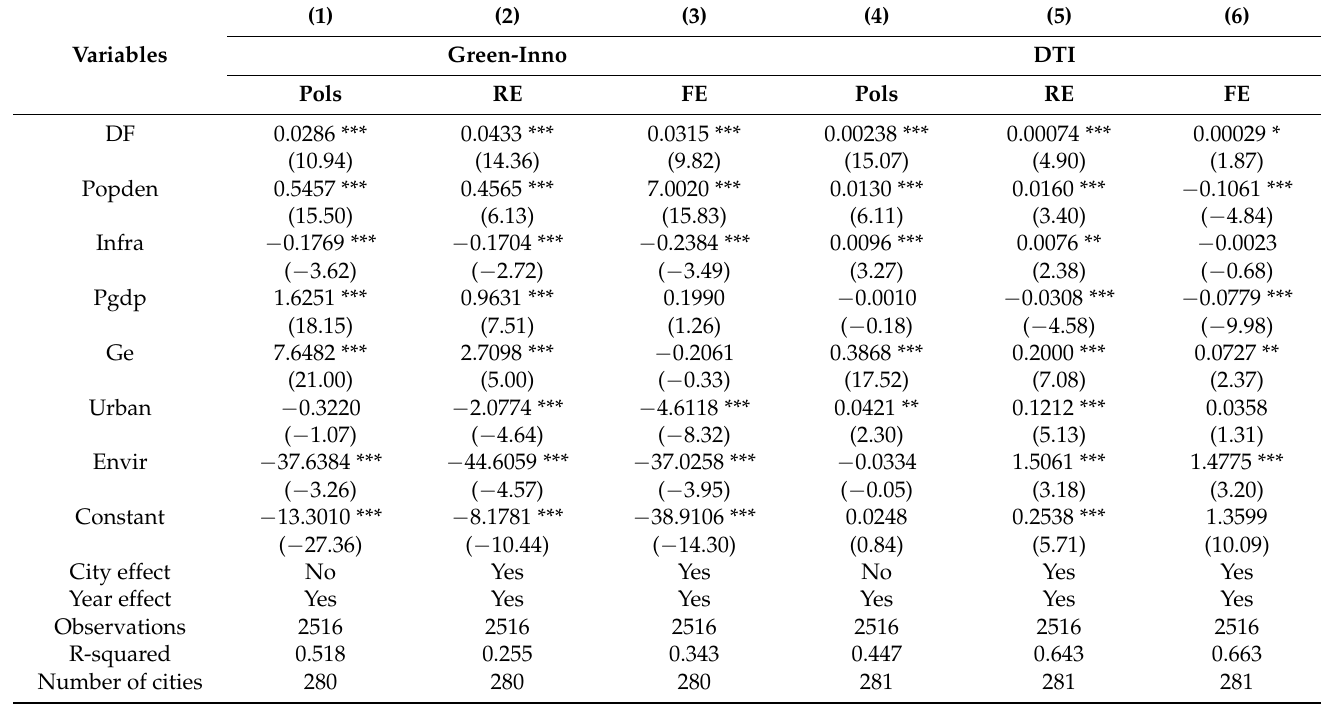
Table 8. Channel tests.